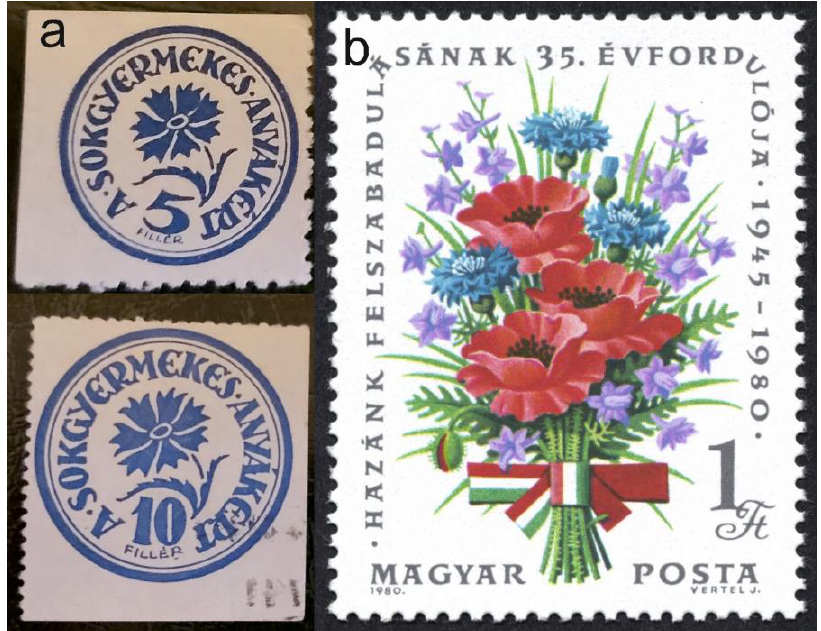
Figure 14. Stamps with cornflower motifs: ( a ) “ For the mothers with many children ”, a series of charity stamps issued by the “ cornflower-action ” movement (192 9 – 1939 ) (Courtesy of Bedő Papírmúzeum); ( b ) a Hungarian postal stamp with arable wildflowers (1980) (Designer József Vertel, Courtesy of Magyar Posta).